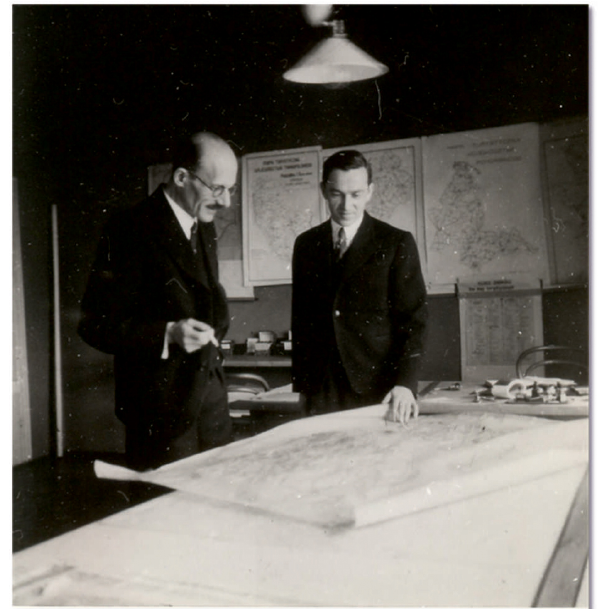
Figure 2. Stanislaw Leszczycki, head of the school, with Jerzy Smolenski during a seminar, 1936 (source: the archives of Antoni